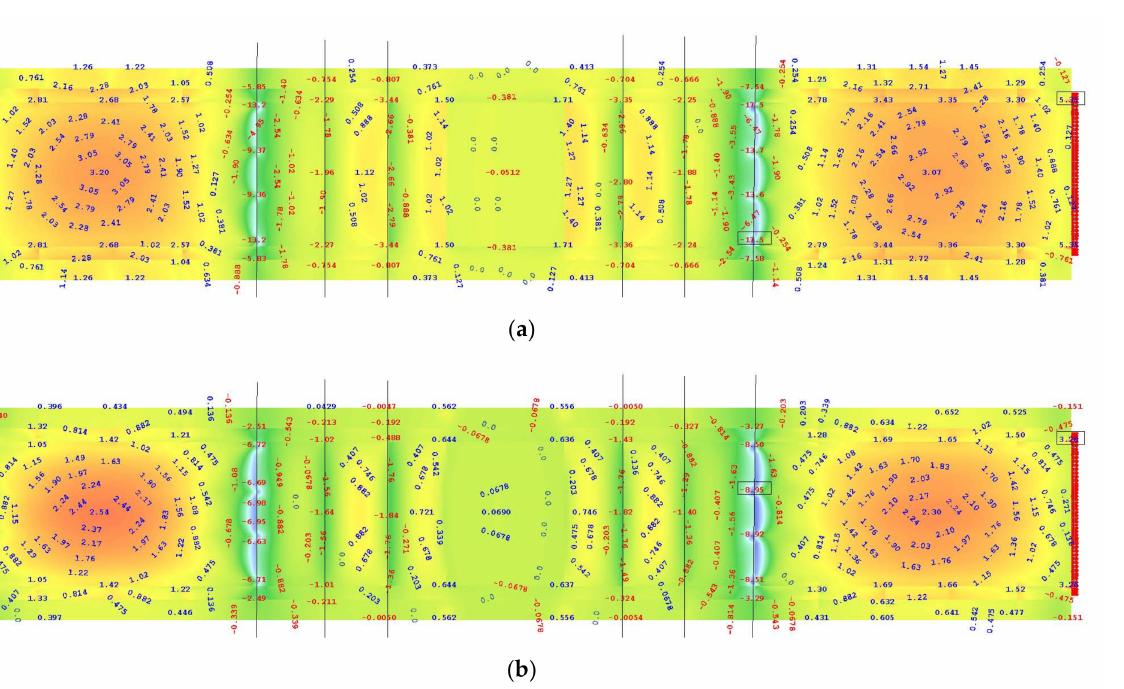
Figure A1. Maps of characteristic values of bending moments M xx (kNm) in the deck slab: ( a ) Dead weight; ( b ) bridge equipment